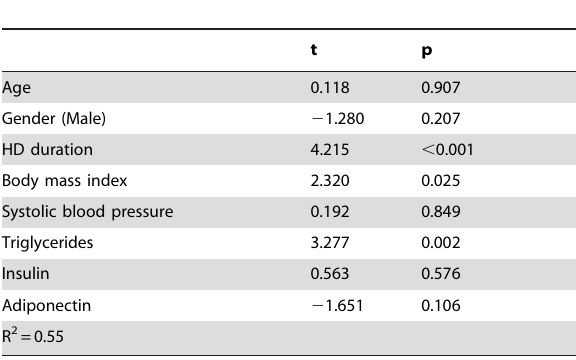
Table 2. Multiple regression analysis for log